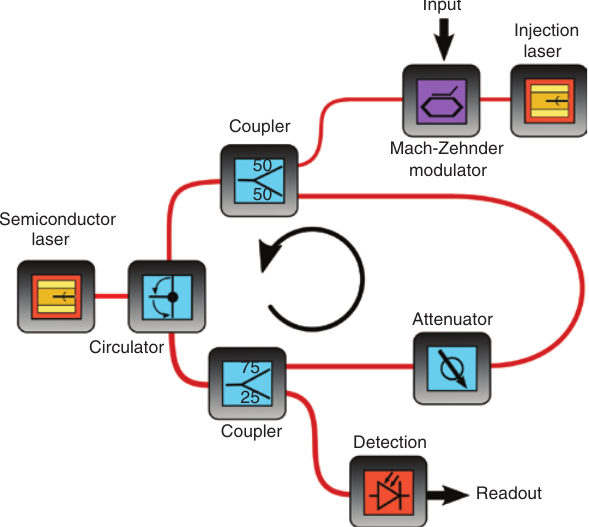
Figure 9: Scheme of the all-optical reservoir computer based on a semiconductor laser subject to delayed optical feedback. The experimental setup comprises the laser diode, a tunable laser source to optically inject the information, a Mach-Zehnder modula- tor, an optical attenuator, a circulator, couplers, and a fast photo diode (PD) for signal